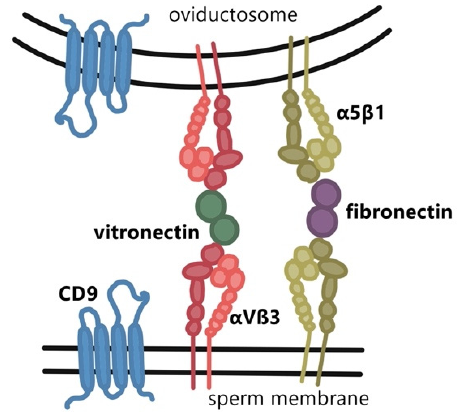
Figure 2. Interaction of sperm and oviductosome membranes via integrin heterodimers.